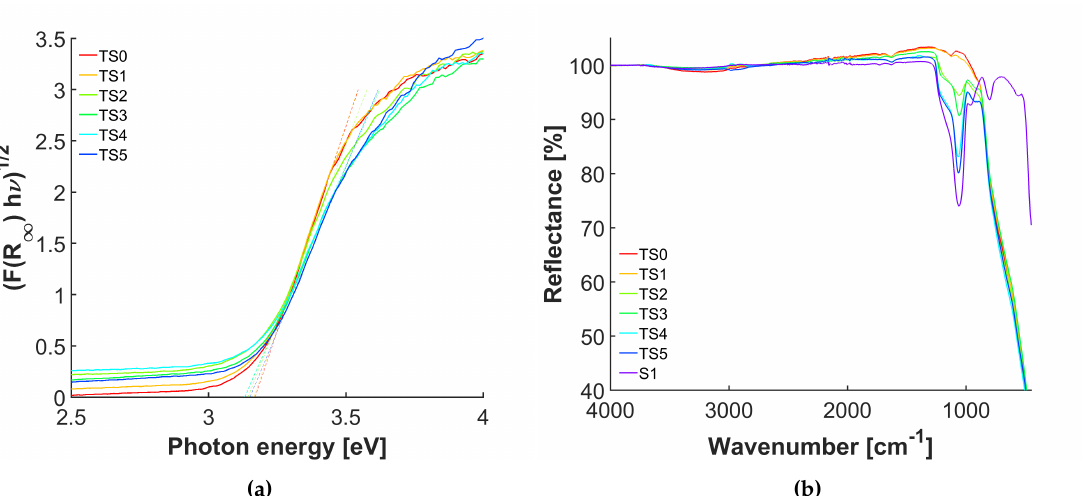
Figure 3. ( a ) Band gap plots of anatase and samples TS1-5; ( b ) ATR-FTIR spectra of anatase, S1, and samples